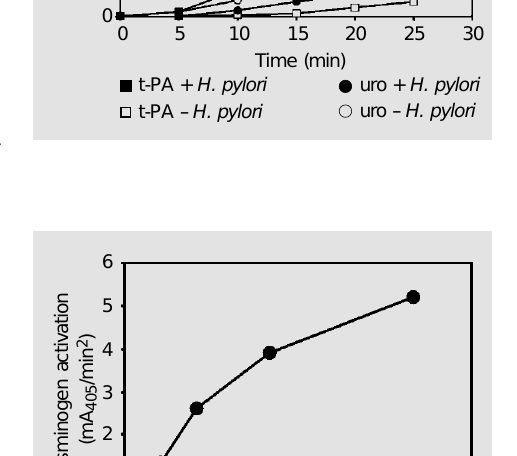
sence (open symbols) of 10 8 H.